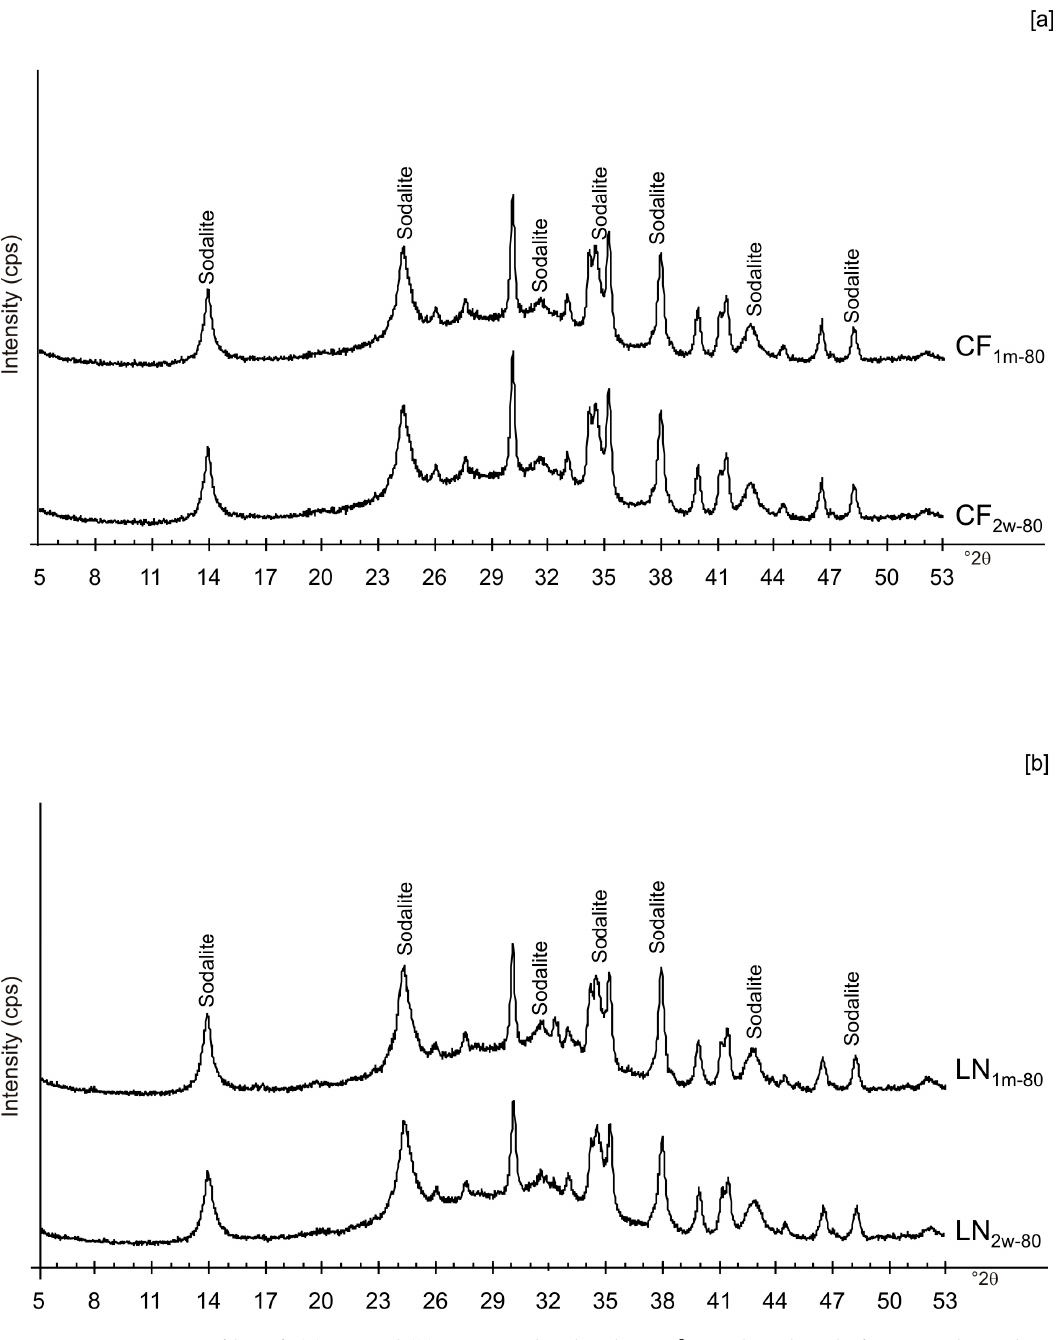
Figure 6. XRPD profiles of: ( a ) CF and ( b ) LN samples dried at 80 °C and analysed after 2 weeks and 1 month.